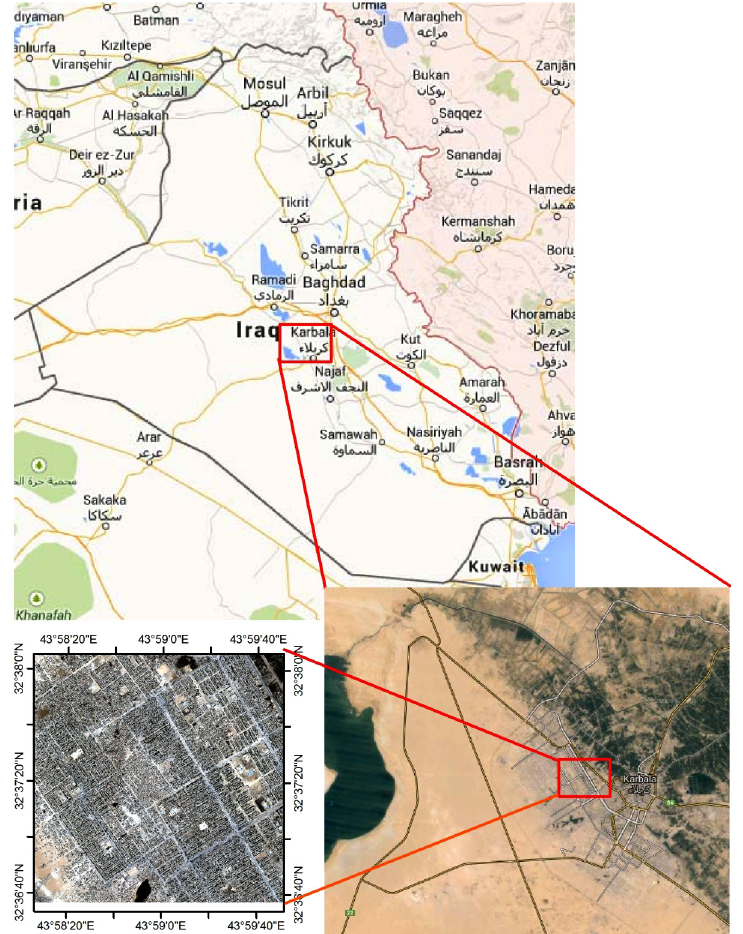
Figure 1. The study